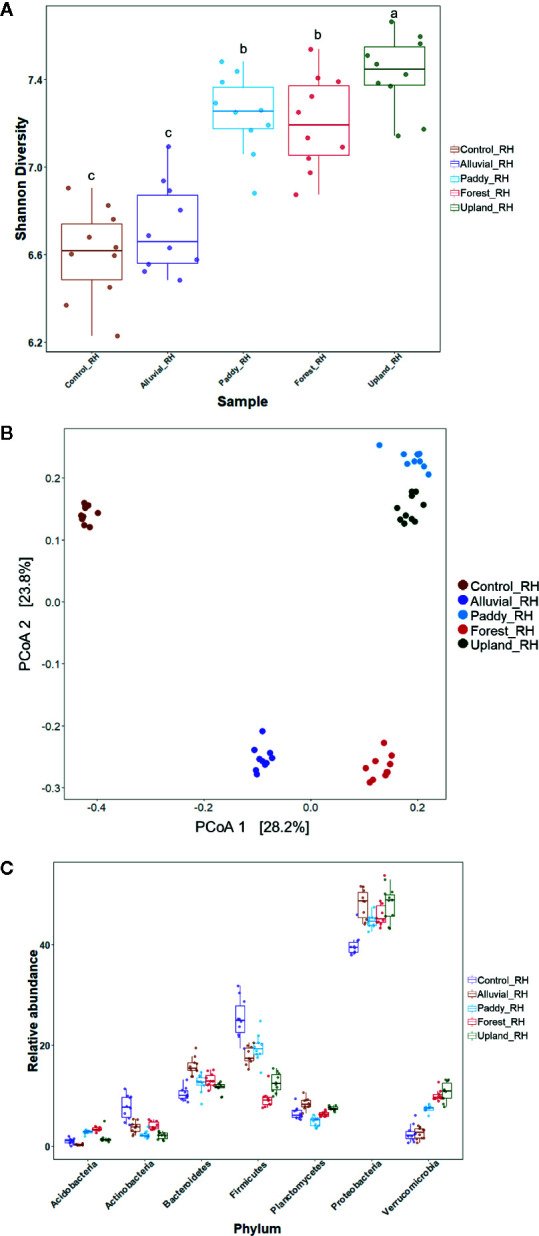
Microbial community analysis of rhizosphere in the Hawaii 7996 cultivar treated with different soil microbial fractions (MFs). (A) Comparative alpha-diversity analysis of bacterial community among the bacterial wilt (BW)-resistant Hawaii 7996 cultivars treated with four different MFs. Shannon diversity index (H′) is calculated after subsampling (p < 0.05, ANOVA with HSD post hoc test). Different letters indicate significant differences. (B) Comparative beta diversity analysis of bacterial community among the BW-resistant Hawaii 7996 cultivars treated with four different MFs. The distribution pattern of four rhizosphere microbiomes in the BW-resistant cultivars evaluated using nonmetric multidimensional scaling based on the Bray–Curtis dissimilarity measures. (C) Relative abundance (%) of the major bacterial phyla in the rhizosphere microbiota of the BW-resistant cultivar treated with four different soil MFs.